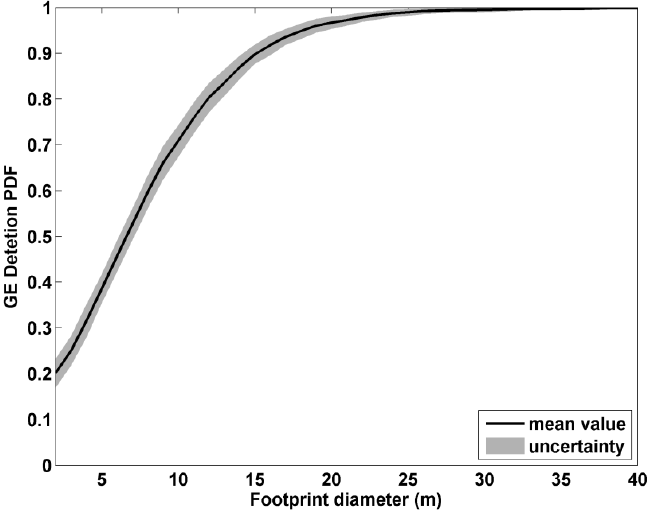
Figure 8. The probability density functions (PDF) of the good detection of the ground echo (GE) vs. footprint